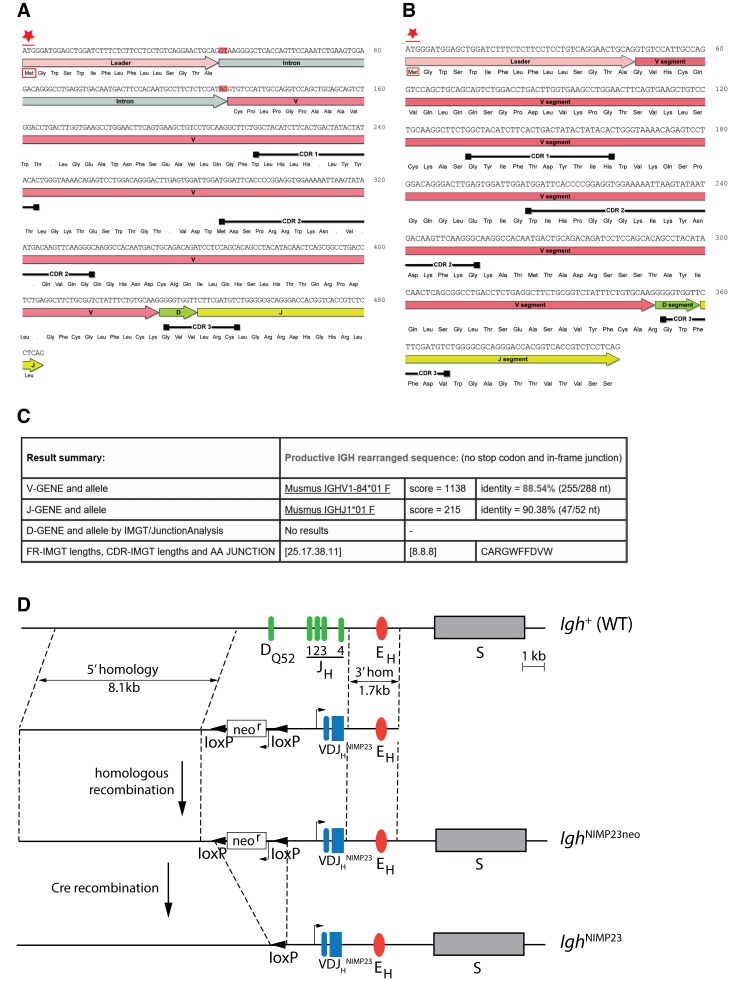
Generation of IghNIMP23/+knock in mice.Annotated DNA and corresponding amino acid sequence of VDJHNIMP23 obtained from (A) gDNA including the Leader-V intron and (B) cDNA, of the NIMP23 hybridoma: start Methionine (Met) indicated by red star, intron splice donor and acceptor sites highlighted in red, dots indicate STOP codons, black bars indicate predicted complementarity determining regions according to the Kabat database (Johnson and Wu, 2001) (C) IMGT/V-Quest mouse Ig database (Lefranc et al., 1999) comparative analysis result summary of the gDNA derived VDJHNIMP23 sequence reveals the identity of the closest matching endogenous V and J genes (D) Schematic representation of (Igh+) Endogenous IgH locus showing the 4 JH segments, the DQ52 element, the Igh intronic enhancer (EH), the switch region for the constant µ gene (S), and (below) targeting construct indicating 5’ and 3’ homology arms and the inverted loxP-neor-loxP cassette and rearranged VDJHNIMP23 variable heavy chain region gene of the NIMP23 hybridoma, replacing DQ52 and all four JH segments of the endogenous IgH gene. IghNIMP23neo: Targeted Igh locus after homologous recombination. IghNIMP23: Final allele after Cre-mediated removal of neor.